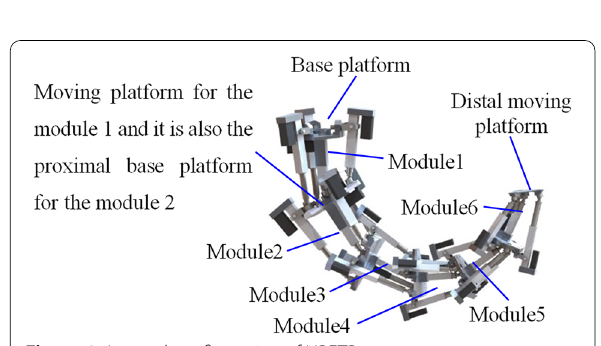
Figure 3 Integral configuration of